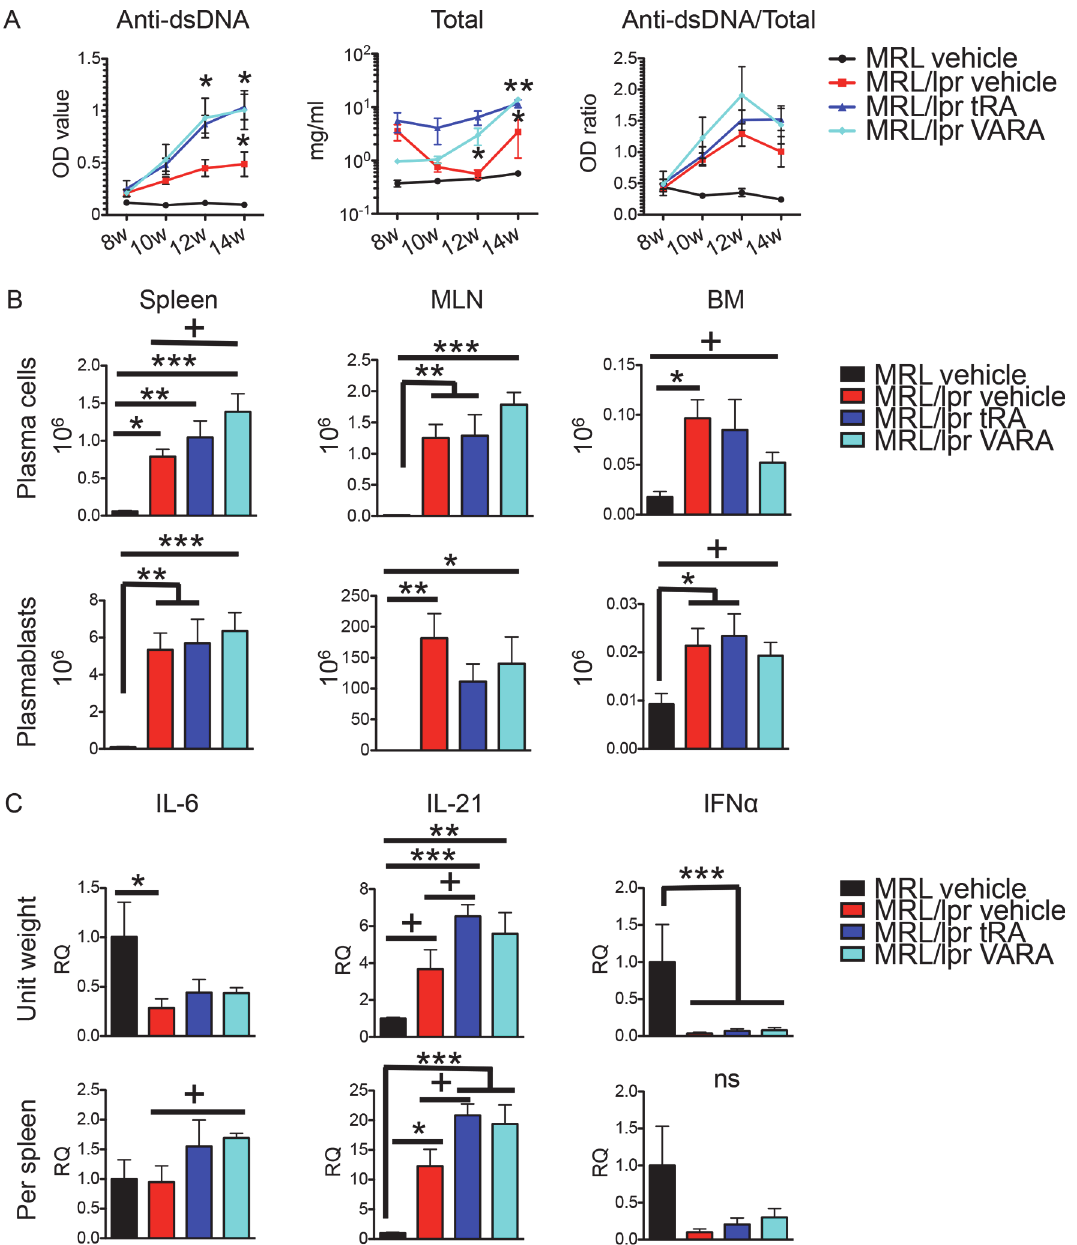
Fig 5. Vitamin A-mediated increase of B-cell responses. (A) Anti-dsDNA IgG, total IgG, and their ratios in the plasma of 8-, 10-, 12- and 14-week-old mice as determined by respective ELISA. One-way ANOVA at each time point was performed but only comparisons between a vitamin A group (either tRA or VARA) and the MRL/lpr vehicle group are labeled in the graphs for simplicity. Although not labeled here, the MRL vehicle group is statistically different from all other groups. Data are shown as mean ± SEM (n = 6). (B) The absolute cell numbers of plasma cells (CD19 - CD27 - CD138 + CD44 + ) and plasmablasts (CD19 +/low CD27 +/low CD138 + CD44 + ) in the spleen, MLN, and BM at 14 weeks old as measured by flow cytometry. (C) mRNA levels of IL-6, IL-21, and IFN α in the spleen at 14 weeks old as determined by RT-qPCR. Relative quantities (RQ) of cytokine mRNA were normalized to that of L32. The average RQ value of MRL vehicle group was defined as 1. ns: not significant, * P < 0.05, ** P < 0.01, *** P < 0.001, one-way ANOVA; +: P < 0.05, student ’ s t -test. Except for (A), data are shown as mean + SEM (n = 6 mice in each group).